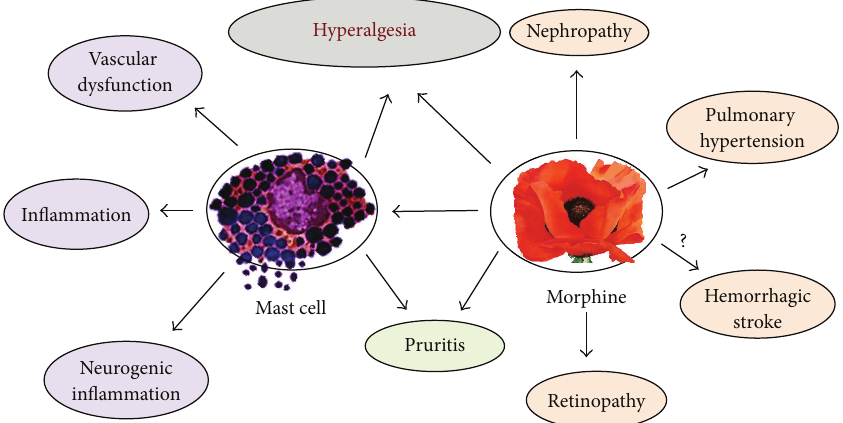
Figure 3: Proposed model of mast cell mediated as well as direct effects of morphine on vascular dysfunction and organ damage. Directly as well as via mast cell activation morphine may augment vascular dysfunction and inflammation. Through its multicellular and organ specific activities, morphine may influence hyperalgesia (pain), retinopathy, pruritis, stroke, pulmonary arterial hypertension, and nephropathy in